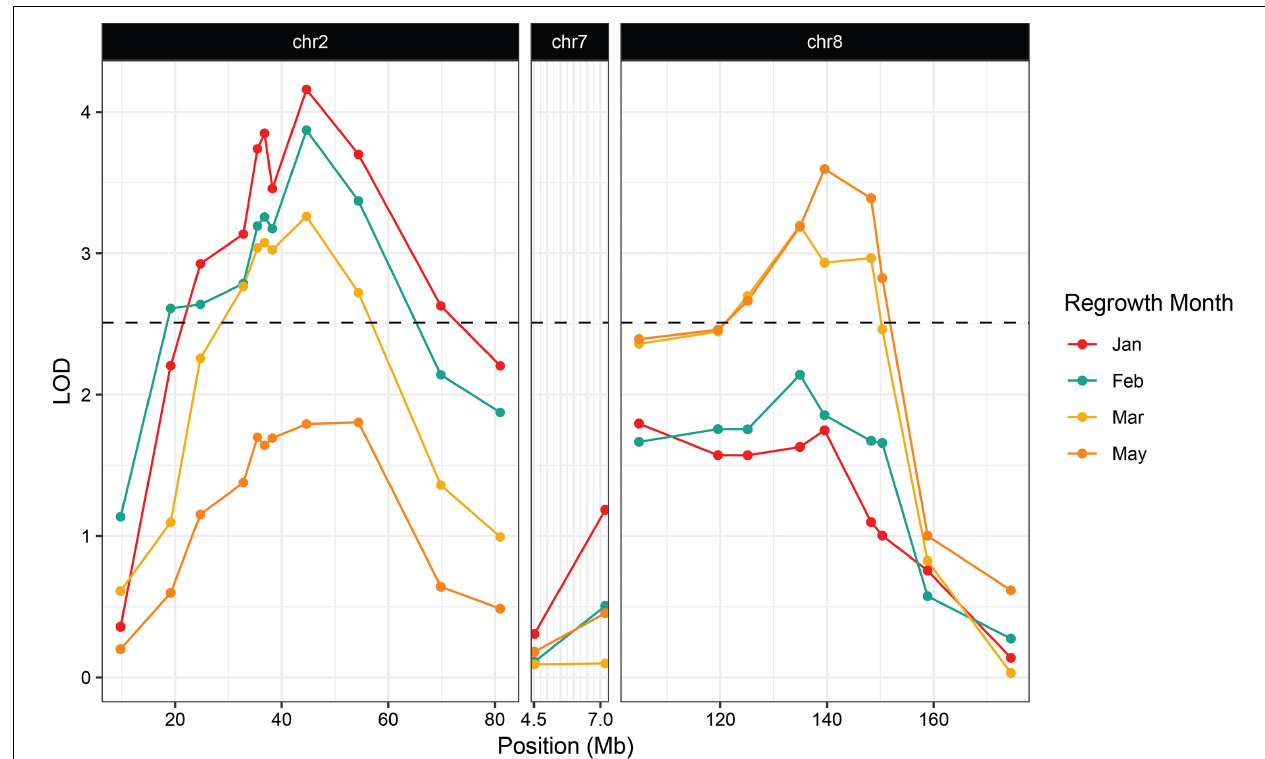
FIGURE 3 | Association between regrowth and markers on chromosomes 2, 7, and 8 in the 2019 P39/“Gigi” F 2 population. QTL were considered significant if the LOD score exceeded the 95% threshold determined by 1000 random permutations of the data for each trait. The threshold was calculated independently for each time point. February had the highest threshold of LOD = 2.51 and was used here as the significance cutoff (dashed line).